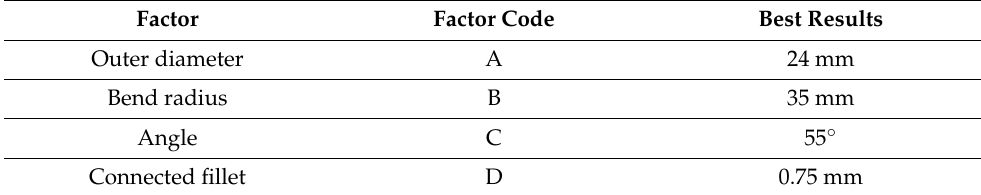
Table 3. Optimal design size combination.